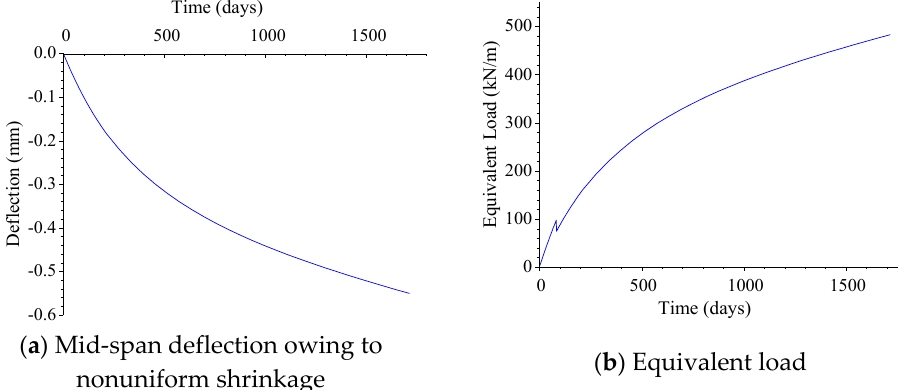
Figure 6. Mid-span deflection owing to nonuniform shrinkage and equivalent load for the short-span PSC beam.